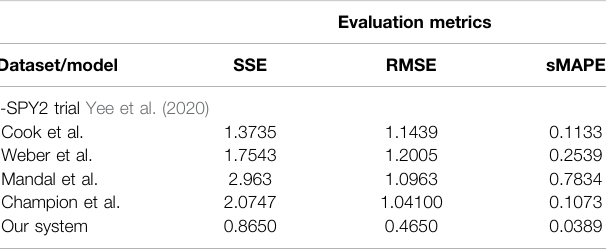
TABLE 8 | Evaluation of the data-driven relation learning systems on real patient breast cancer